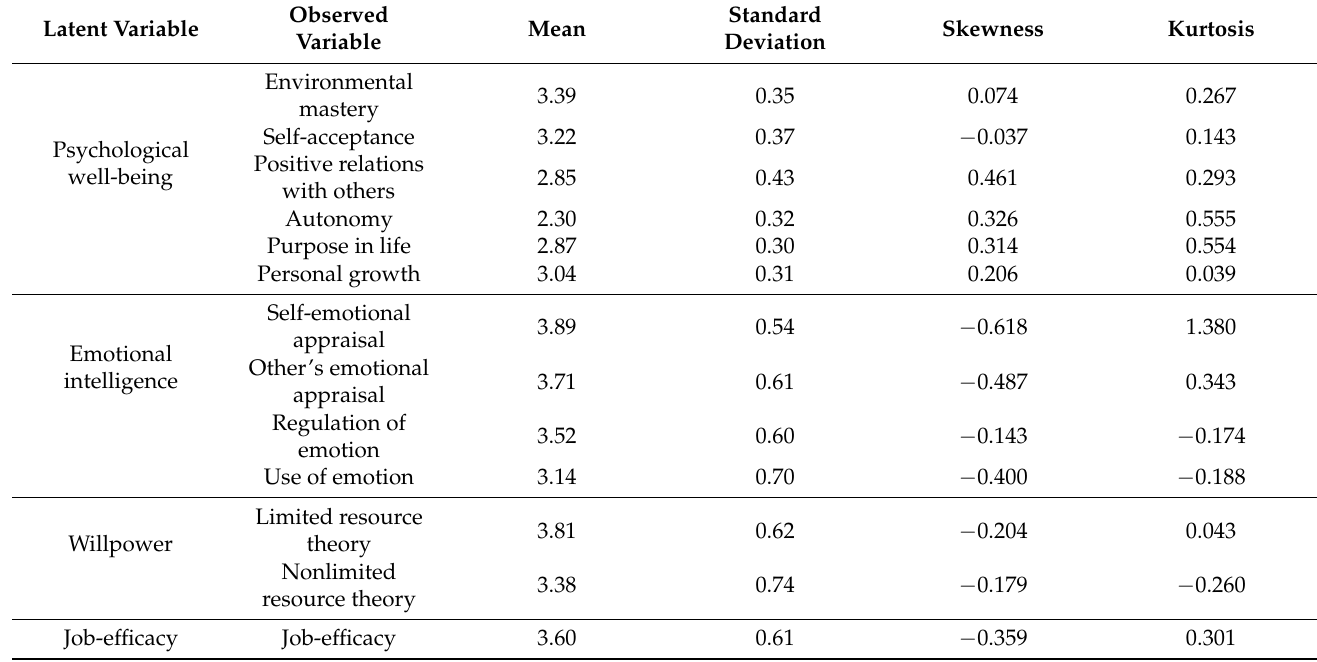
Table 2. Technical metrics of the measurement variables ( n =